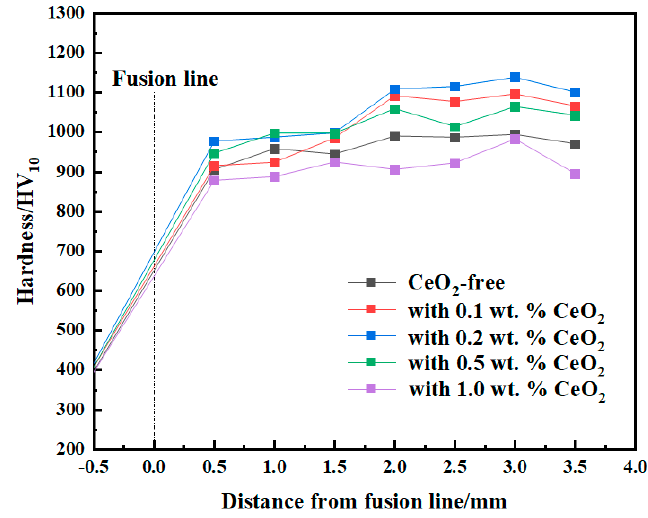
Figure 6. Hardness of the Ni-based tungsten carbide cladding layer with different CeO 2 contents.